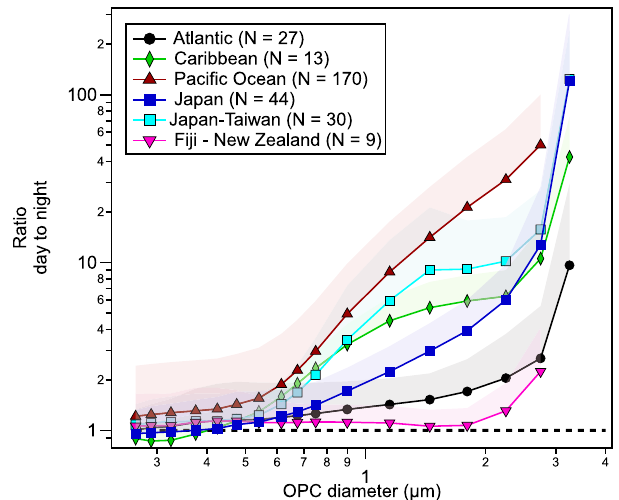
Fig. 2 Mean day-to-night aerosol count ratio for each bin of the optical particle counter (OPC) for different regions across Tara ’ s route. The shaded areas represent 1 σ , and only the top parts are shown for clarity. N refers to the number of days